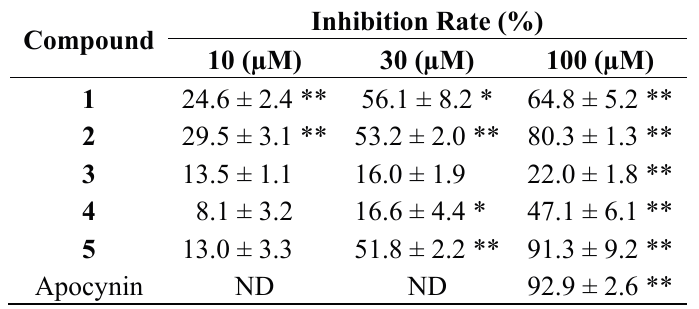
Table 3. Effects of isolated compounds on the production of intracellular ROS in LPS-stimulated RAW 264.7